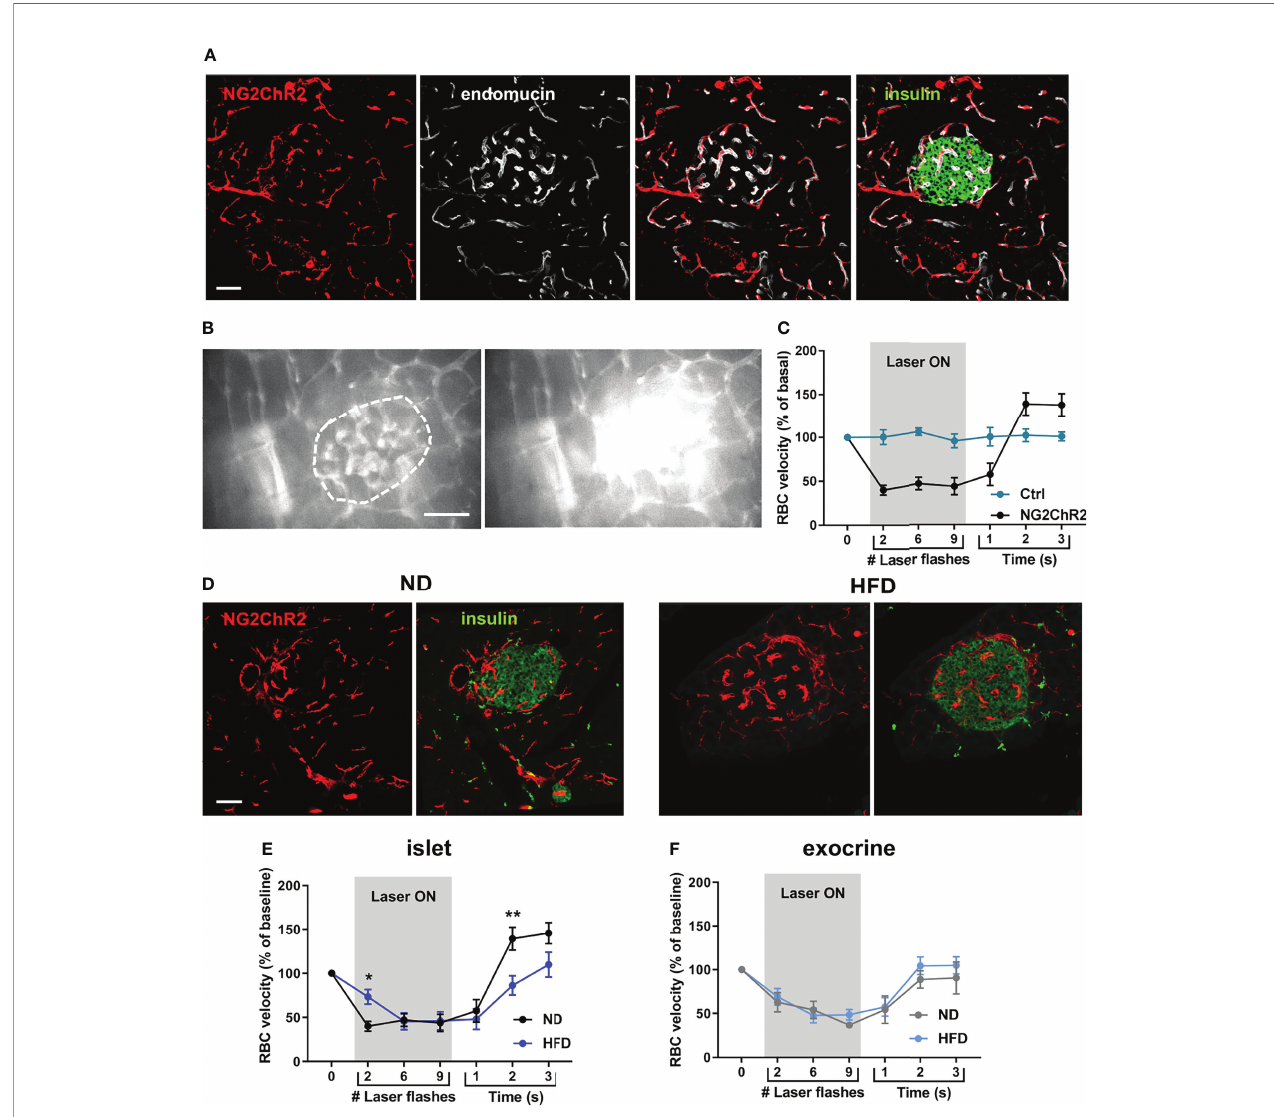
FIGURE 3 | Optogenetic stimulation of islet pericytes reveals functional alteration following HFD. (A) Confocal images of a pancreatic islet of a NG2ChR2 mouse (scale: 50 µm, 22 µm Z-projection; red: NG2ChR2, green: insulin, white: endomucin). (B) Still images from an in vivo movie of blood fl ow showing blood fl ow alteration upon laser stimulation focused on an islet (473 nm, 150 ms, 1 Hz, 200 µm fi ber at <0.5 mm of tissue) (See also Video S2 ) (scale: 50 µm). Vessel parenchyma was labeled with Rhodamine-dextran, allowing laser fl ashes to be clearly visible. Islet is circled. (C) Quanti fi cation of red blood cell (RBC) velocity in control (ChR2-Tomato or NG2-Cre mice) and NG2-ChR2 mice before, during and after laser stimulation (473 nm, 150 ms, 1 Hz, 10 fl ashes). Data is presented as mean ± SEM. RBC velocity is signi fi cantly reduced during laser stimulation in NG2-ChR2-Tomato mice (n= 3-6 mice/condition, 5-10 vessels/mouse, Two-way ANOVA). (D) Confocal images of a pancreatic islets of NG2ChR2 mice fed with normal diet (ND) (left) or high-fat diet (HFD) (right) (scale: 50 µm, 1 µm Z-projection; red: NG2ChR2, green: insulin). (E) Quanti fi cation of red blood cell (RBC) velocity in islets of ND-fed and HFD-fed mice before, during and after laser stimulation (473 nm, 150 ms, 1 Hz, 10 fl ashes). Data is presented as mean ± SEM. RBC velocity measurement shows delayed decrease and recovery of blood fl ow in HFD-fed animals (n= 3-6 mice/condition, 5-10 vessels/mouse, Two-way ANOVA). (F) Quanti fi cation of red blood cell (RBC) velocity in exocrine tissue of ND-fed and HFD-fed mice before, during and after laser stimulation (473 nm, 150 ms, 1 Hz, 10 fl ashes). Data is presented as mean ± SEM. RBC velocity measurement shows delayed decrease and recovery of blood fl ow in HFD-fed animals (n= 3-6 mice/condition, 5-10 vessels/mouse, Two-way ANOVA). *P < 0.05, **P <